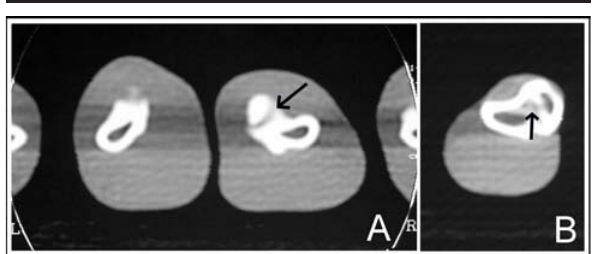
FIGURE 2 - Tomographic oblique sagital reconstruction of the forelimbs at 150 days after surgery. In A, notice the block of graft biomaterial (Gen- TechTM), and areas of bone resorption in the synostosis area between the radius and ulna leaning toward a single medullary canal (arrows). In B, notice the bone formation from the osteotomy sites and from the ulnar surface, filling the defect partially. Also, notice the areas of bone resorption (arrows)